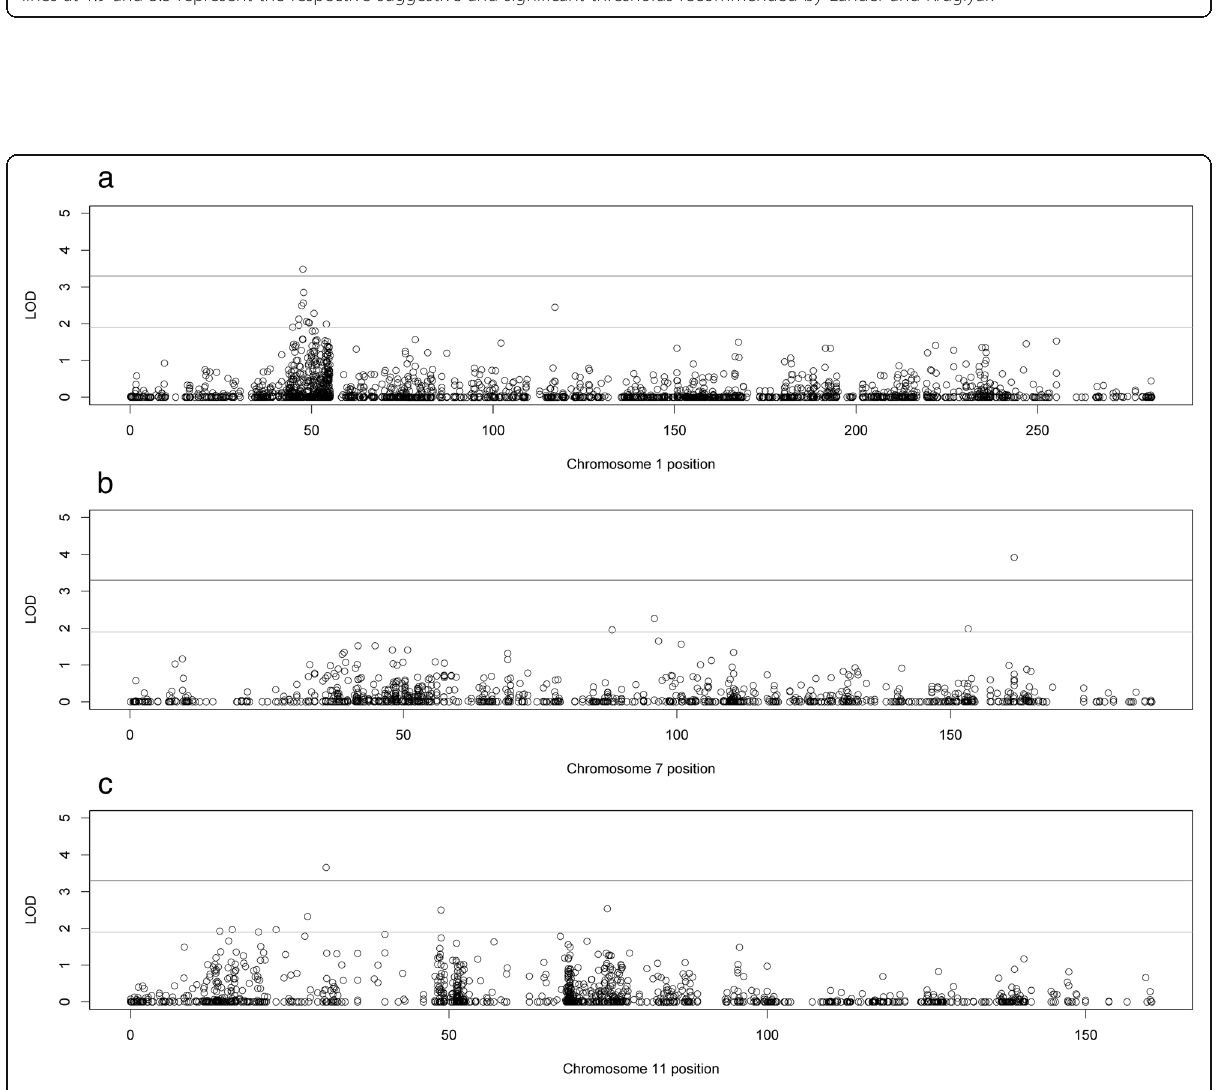
Fig. 4 Genome-wide plot of genome-wide collapsed haplotype pattern heterogeneity LOD (HLOD) scores across the 64 Ashkenazi families. The lines at 1.9 and 3.3 represent the respective suggestive and significant thresholds recommended by Lander and Kruglyak